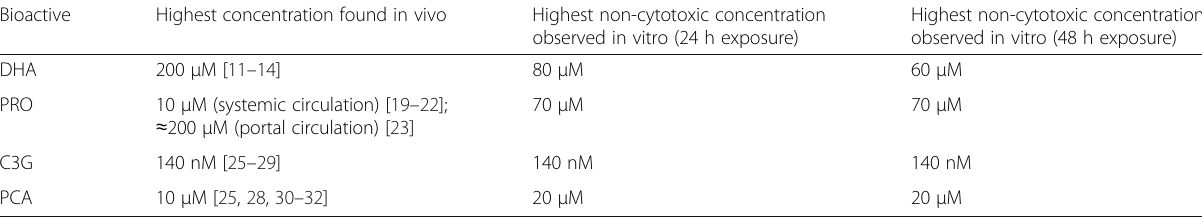
Table 1 Summary of the highest bioactive concentrations found in human plasma compared to the highest non-cytotoxic ones detected in the herein reported in vitro study Bioactive Highest concentration found in vivo Highest non-cytotoxic concentration Highest non-cytotoxic concentration observed in vitro (24 h exposure) observed in vitro (48 h